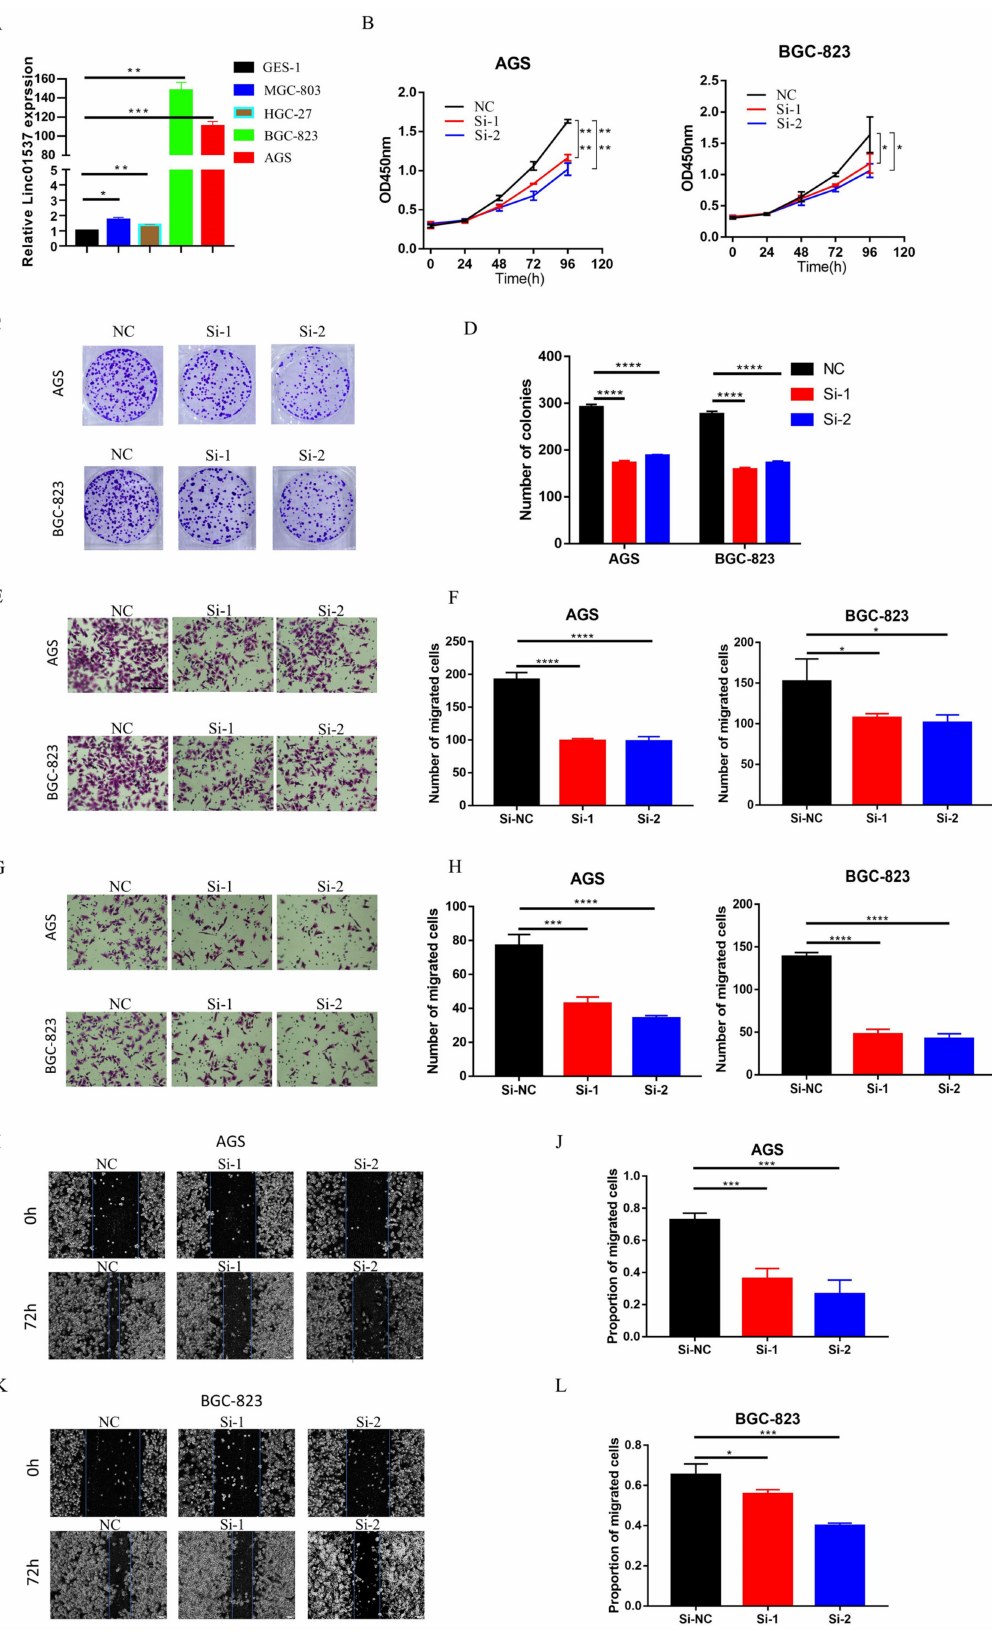
Figure 2. LINC01537 knockdown inhibits proliferation, migration, and invasion of GC cells. ( A ) Expression levels of LINC01537 in GES-1, MGC-803, HGC-27, BGC-823, and AGS were